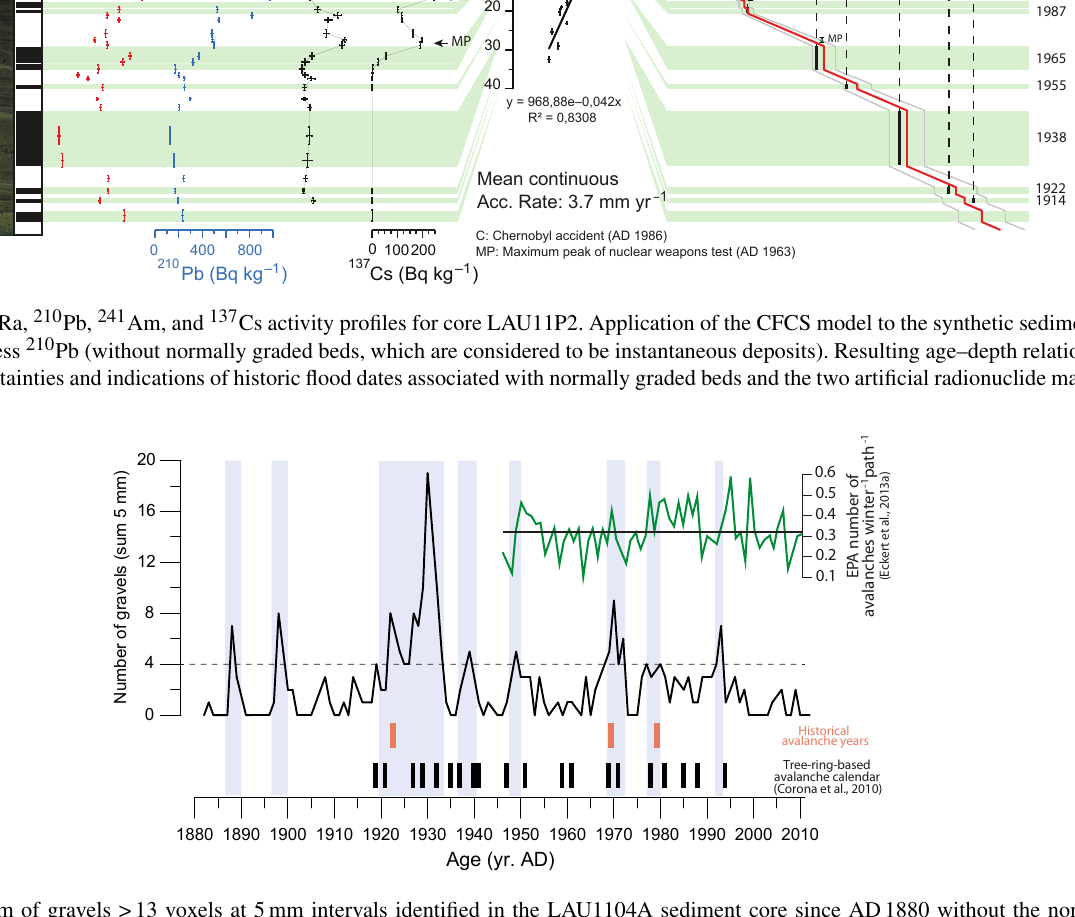
Figure 5. Sum of gravels >13 voxels at 5mm intervals identified in the LAU1104A sediment core since AD1880 without the normally graded beds. The dashed line represents the threshold number from which avalanche periods are identified (highlighted in blue). Exceptional winters found in the bibliography are represented in red (Allix, 1923; Jail, 1970; Ecrins National Park internal report, 1978). EPA (Enquête Permanente sur les Avalanches) number of avalanches per path since AD1950 is in green, and interannual mean value is in black (Eckert et al., 2013). The avalanche record for the past century is from tree rings in the nearby Romanche river valley (Corona et al.,